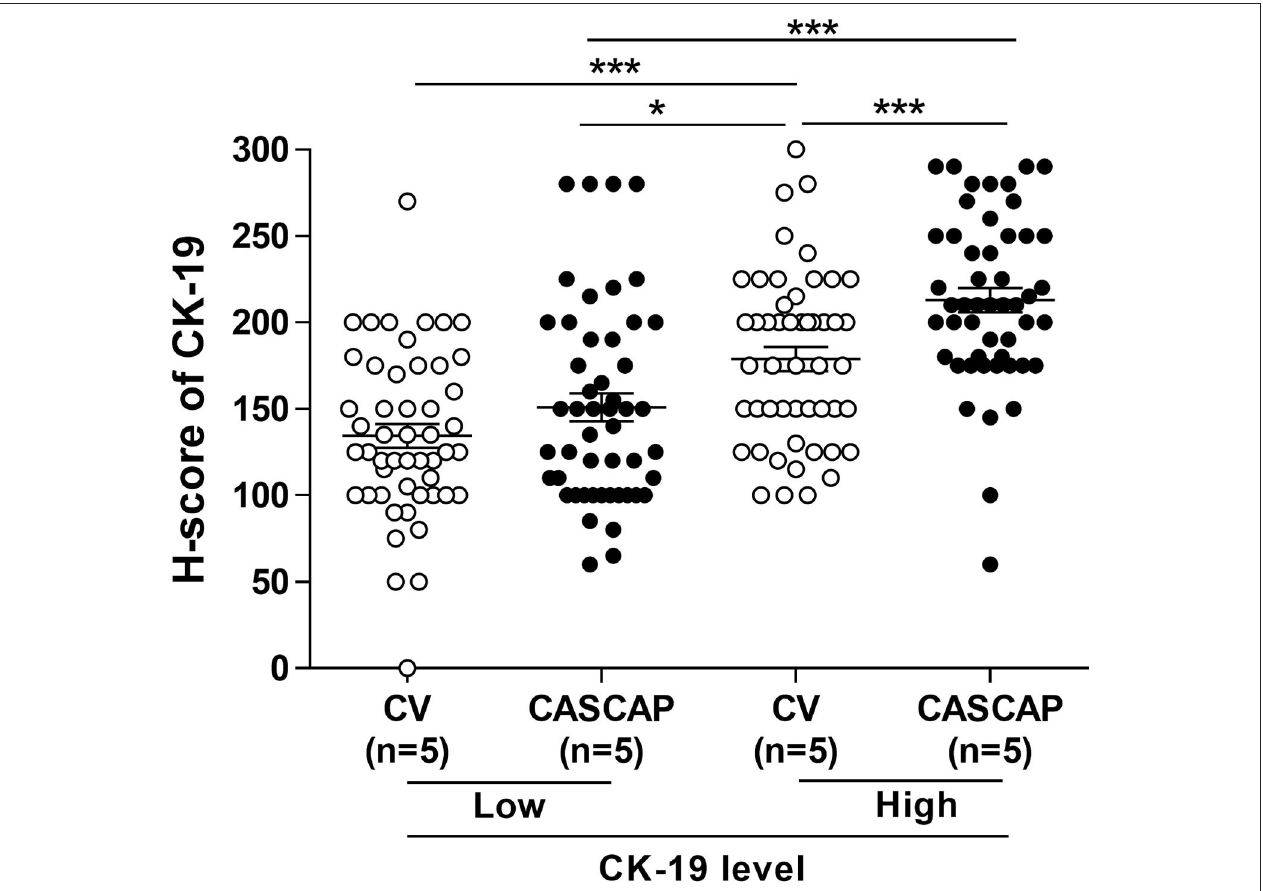
FIGURE 5 | Comparison of low and high CK19 signals between conventional (CV) and new (CASCAP) methods was demonstrated as dot plot. CASCAP, H-score < 180 as low and H-score ≥ 180 as high and CV, H-score < 150 as low and H-score ≥ 150 as high. *p < 0.05 and ***p < 0.001. = 0.125) ( Figure 5 ; Table 5 ). Significantly, the gap between